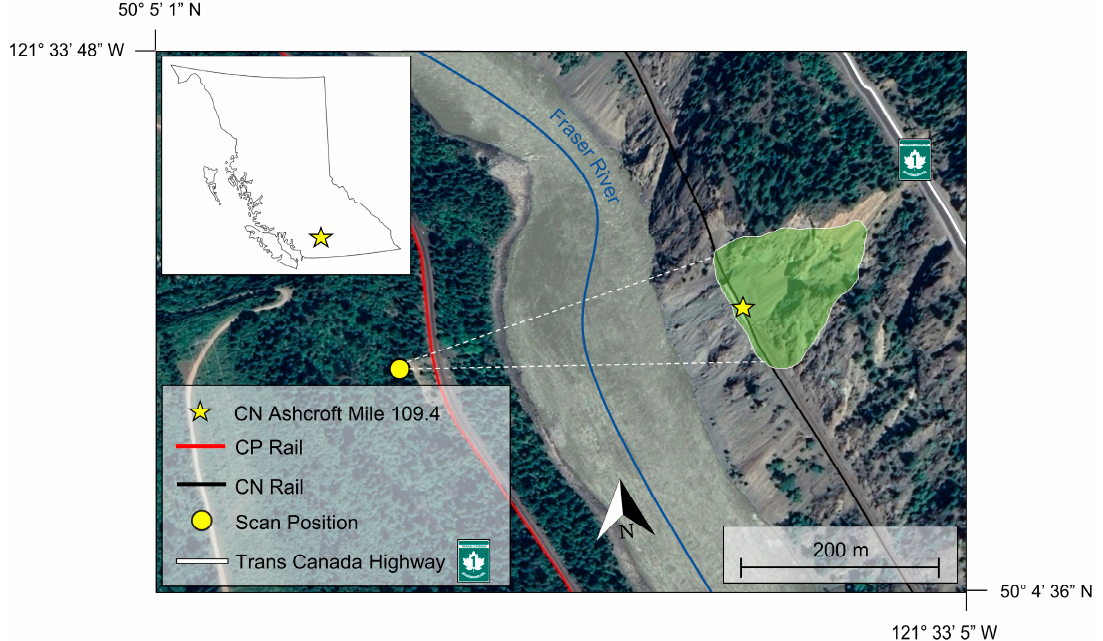
Figure 2. Site map of CN Ashcroft Mile 109.4. Inset image displays site location within the province of British Columbia. Remote Sens. 2020 , 12 , x FOR PEER REVIEW